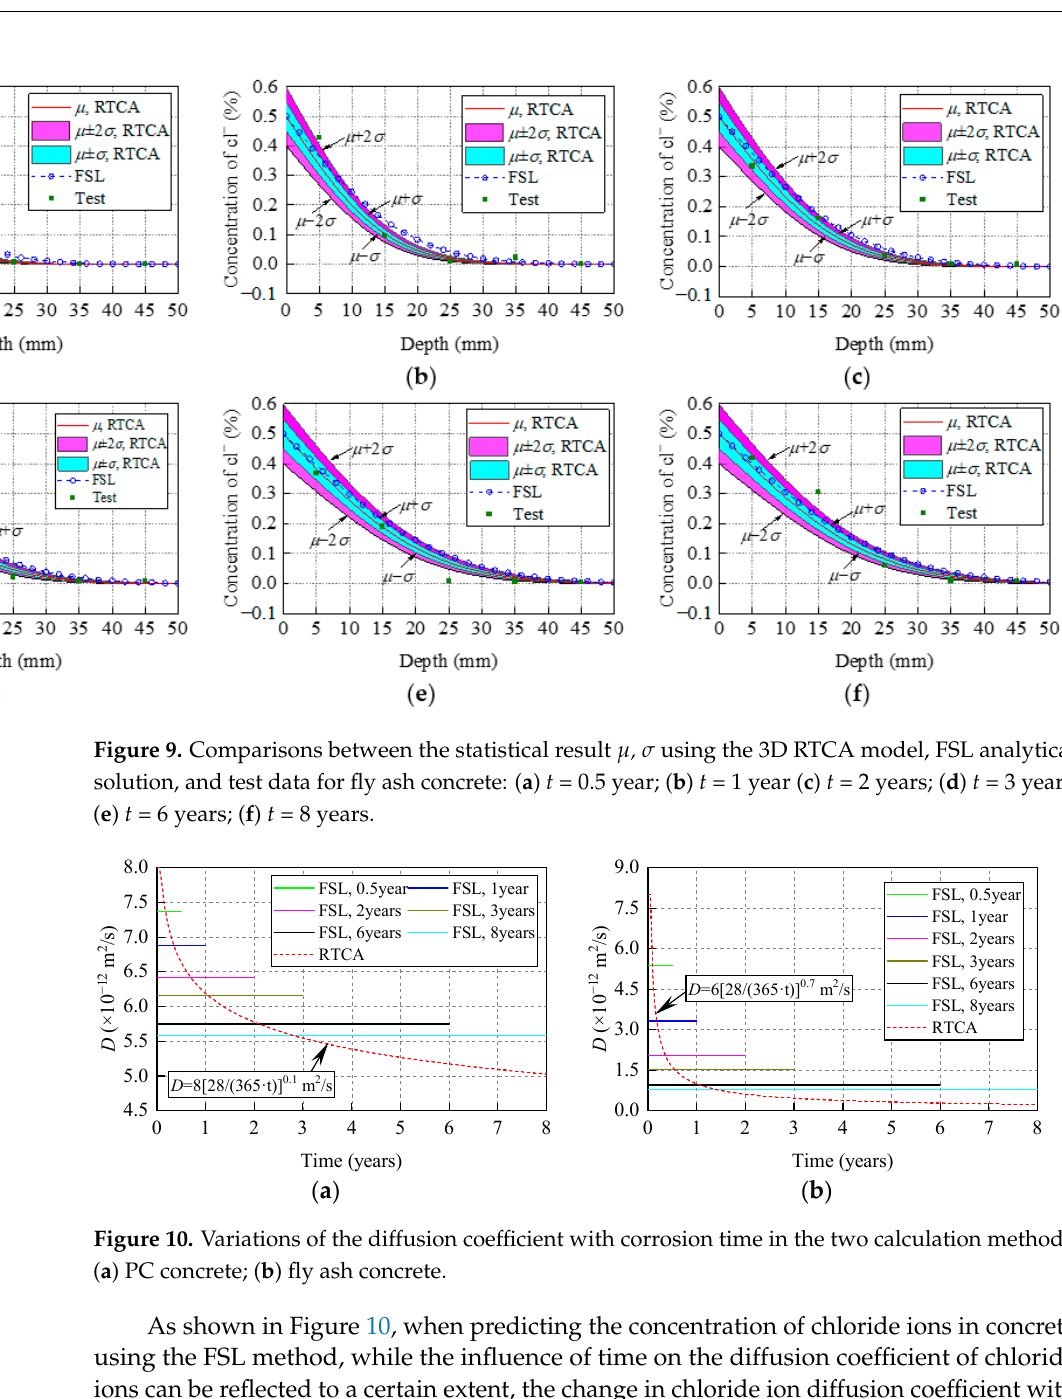
Figure 9. Comparisons between the statistical result μ , σ using the 3D RTCA model, FSL analytical solution, and test data for fly ash concrete: ( a ) t = 0.5 year; ( b ) t = 1 year ( c ) t = 2 years; ( d ) t = 3 years; ( e ) t = 6 years; ( f ) t = 8 years.